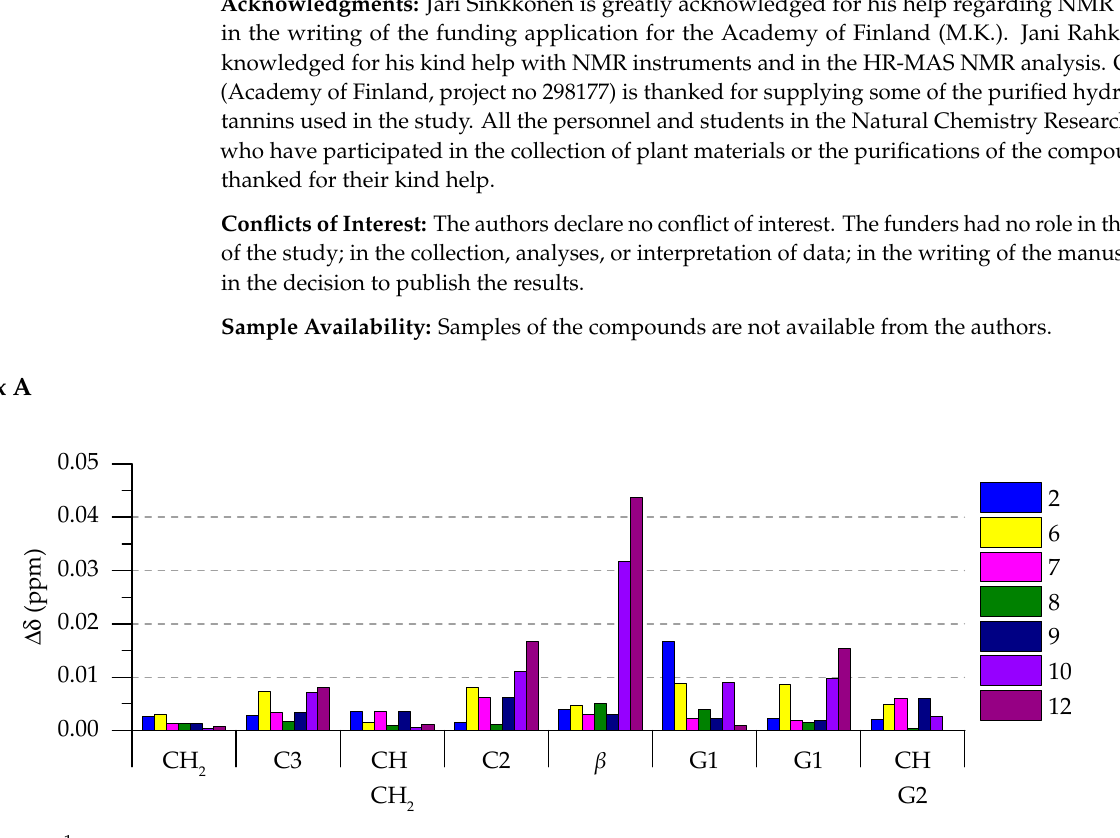
Figure A1. 1 H NMR chemical shift deltas ( Δδ , ppm) of E. coli lipid extracts in the presence of vescalagin 2 , geraniin 6 , chebulagic acid 7 , chebulinic acid 8 , punicalagin 9 , oenothein B 10 , and oenothein A 12 . The tannin numbering refers to Figure 1 and lipid proton assignations refer to Figure 5. Values are presented as Δδ ( n = 1).